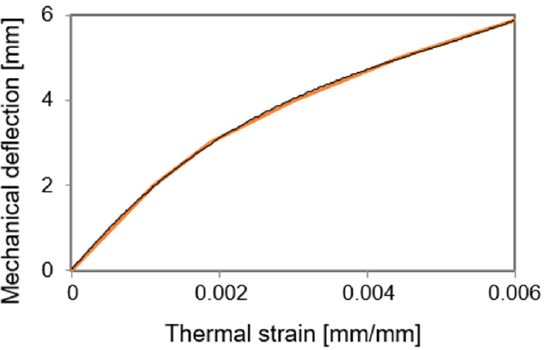
Figure 10. Correlation between mechanical deformation and thermal expansion as result of the conducted simulations.